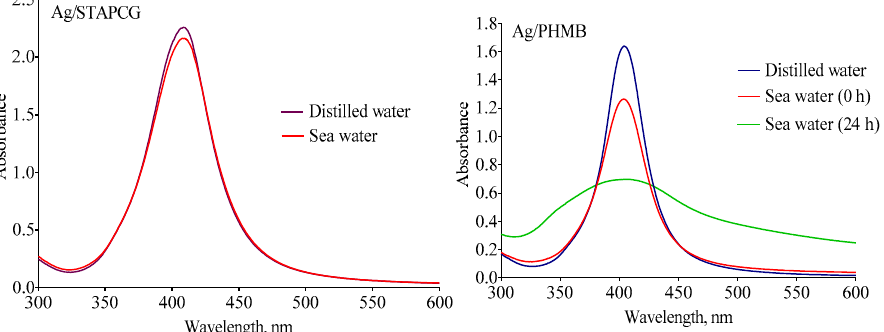
Figure 3. Examples of UV-vis spectra for stable (Ag/STAPCG) and unstable (Ag/PHMB) AgNPs diluted in distilled water and seawater (10–15 mg/L).